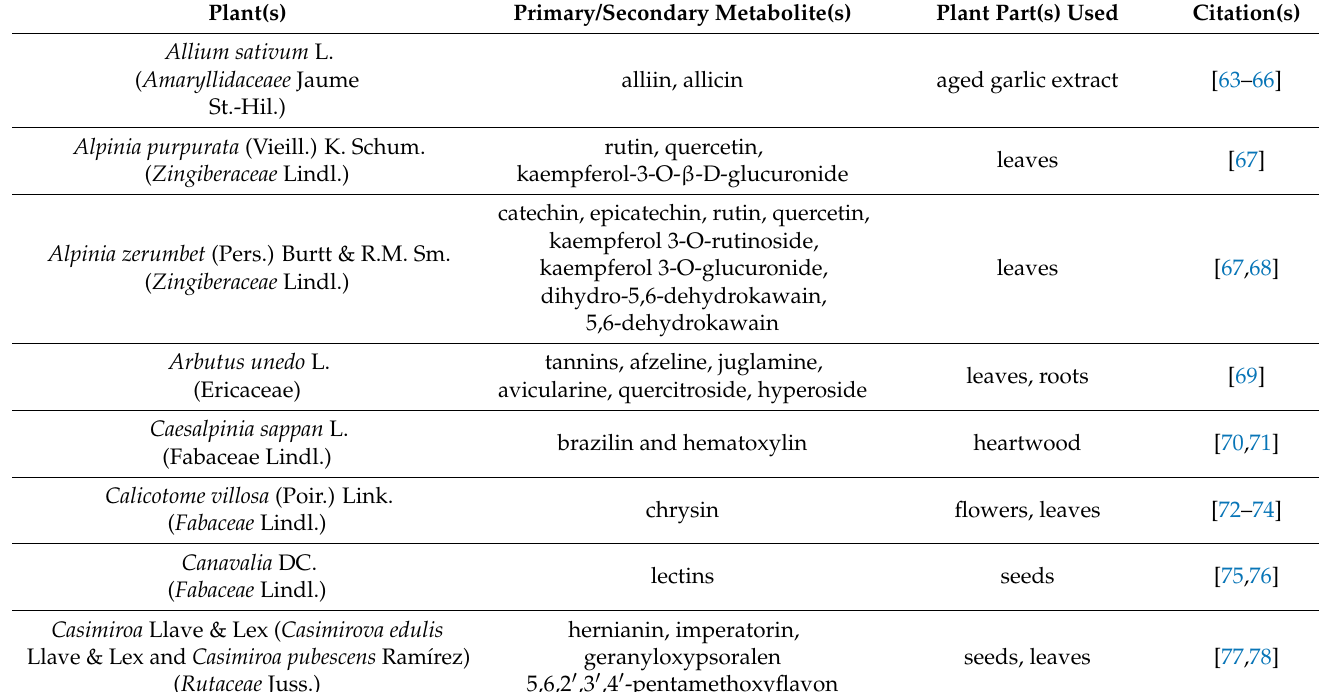
Table 1. Nitric oxide–cyclic guanosine monophosphate activation